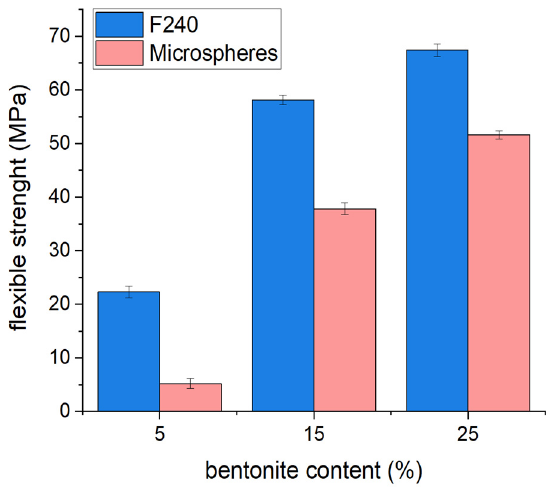
Figure 7. SEM images of fracture surfaces of ceramics based on hollow alumina microspheres (HAM) with 15 wt.% of bentonite binder pressed at ( a ) 30 and ( b ) 40 MPa.